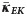
Resulting transition rate values from calibrating the potential immune evasion models to whole-blood infection scenarios with either C. albicans, C. glabrata or S. aureus.Mean values (data points) and standard deviations (error bars and line thickness) of transition rates were quantified by the global parameter estimation algorithm Simulated Annealing based. Dots depict the transition rate values for the spon-IE model (light green), PMNmed-IE model (pink), alivePre-IE model (dark blue), spon-alivePre-IE model (light blue), PMNmed-alivePre-IE model (orange), spon-PMNmed-IE model (red) and spon-PMNmed-alivPre-model (dark green). The transition rates for phagocytosis are defined by ϕN for PMN and by ϕM for monocytes. Intracellular killing rates are defined by κN for PMN and κM\ for monocytes. Transition rates γ and κ-EK determine the time-dependent extracellular killing rate κEK(t). Depending on the chosen model, the transition rates ρ, ρ- and γIE determine the immune-evasion rate over time (ρ(t)). Transition rate values for infection scenario with C. albicans for phagocytosis (A), intracellular killing (B), time course of the extracellular killing rate (C) and the time course of the immune-evasion rate (D). Transition rate values for infection scenario with C. glabrata infection for phagocytosis (E), intracellular killing (F), time course of the extracellular killing rate (G) and time course of the immune-evasion rate (H). Transition rate values for infection scenario with S. aureus infection for phagocytosis (I), intracellular killing (J), time course of the extracellular killing rate (K) and time course of the immune-evasion rate (L). Transition rates and start populations quantified for all base and combined models for each pathogen infection are also shown in S1-S3 Tables of S1 File.